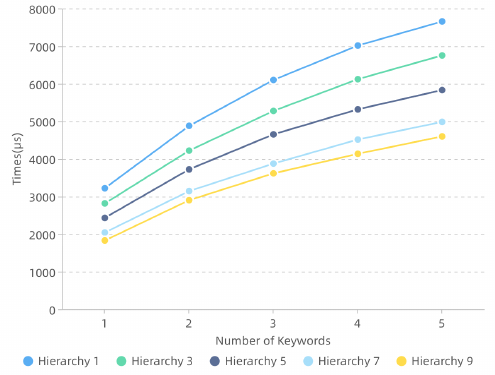
Figure 3. The Relationship of Search Times and Hierarchies.